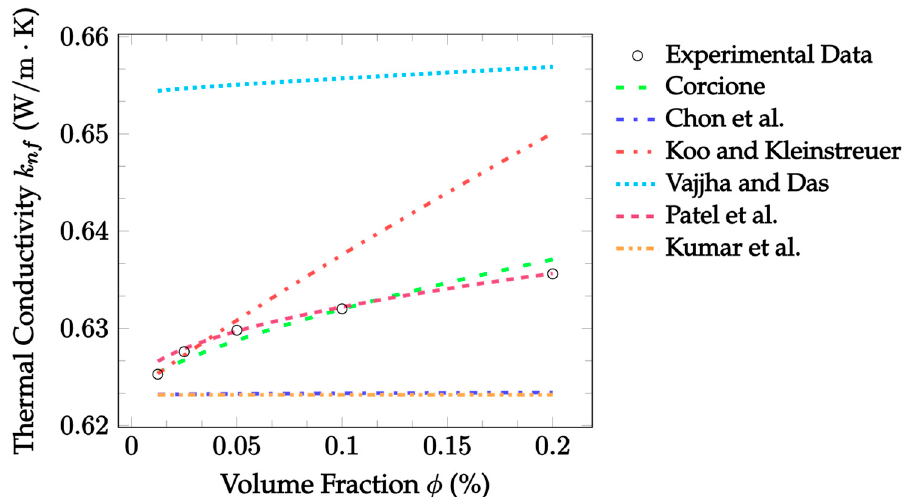
Figure 4. Brownian model predictions and experimental findings for ZrO 2 –water nanofluid at 35 °C, with a particle diameter of 30 nm and volume fractions from 0.0125% to 0.2%: Experimental Data [65], Corcione [19], Chon et al. [20], Koo and Kleinstreuer [21], Vajjha and Das [22], Patel et al. [23], Kumar et al. [24].